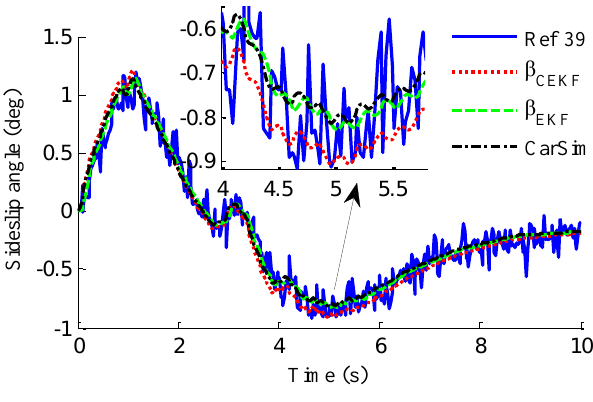
Figure 17. Estimation of sideslip angle.